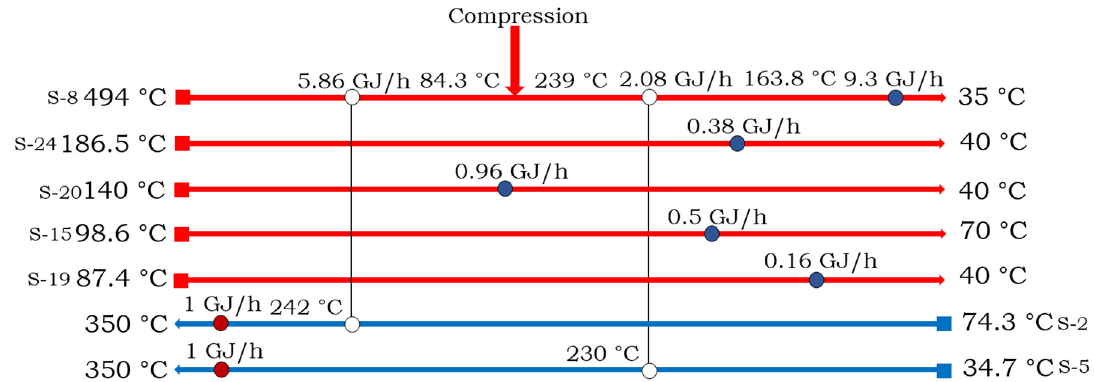
Figure 2. Heat exchanger network of the process streams for the developed process.